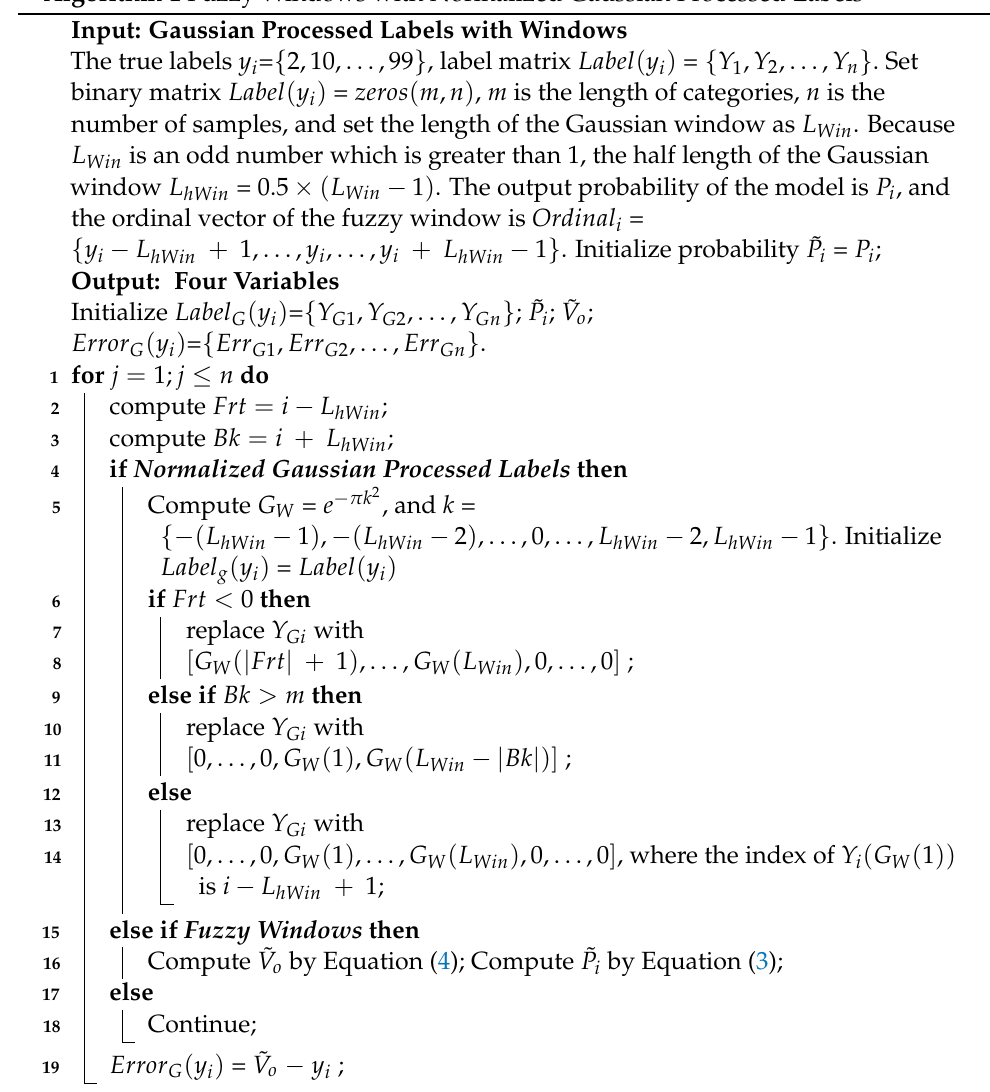
Algorithm 1 Fuzzy Windows with Normalized Gaussian Processed